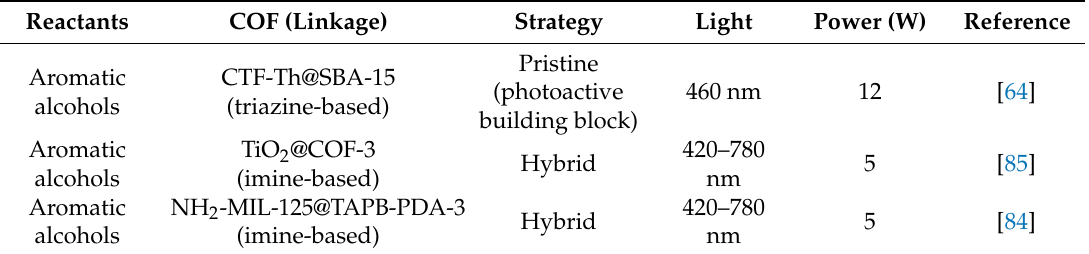
Table 2. Photooxidation reactions of alcohols mediated by